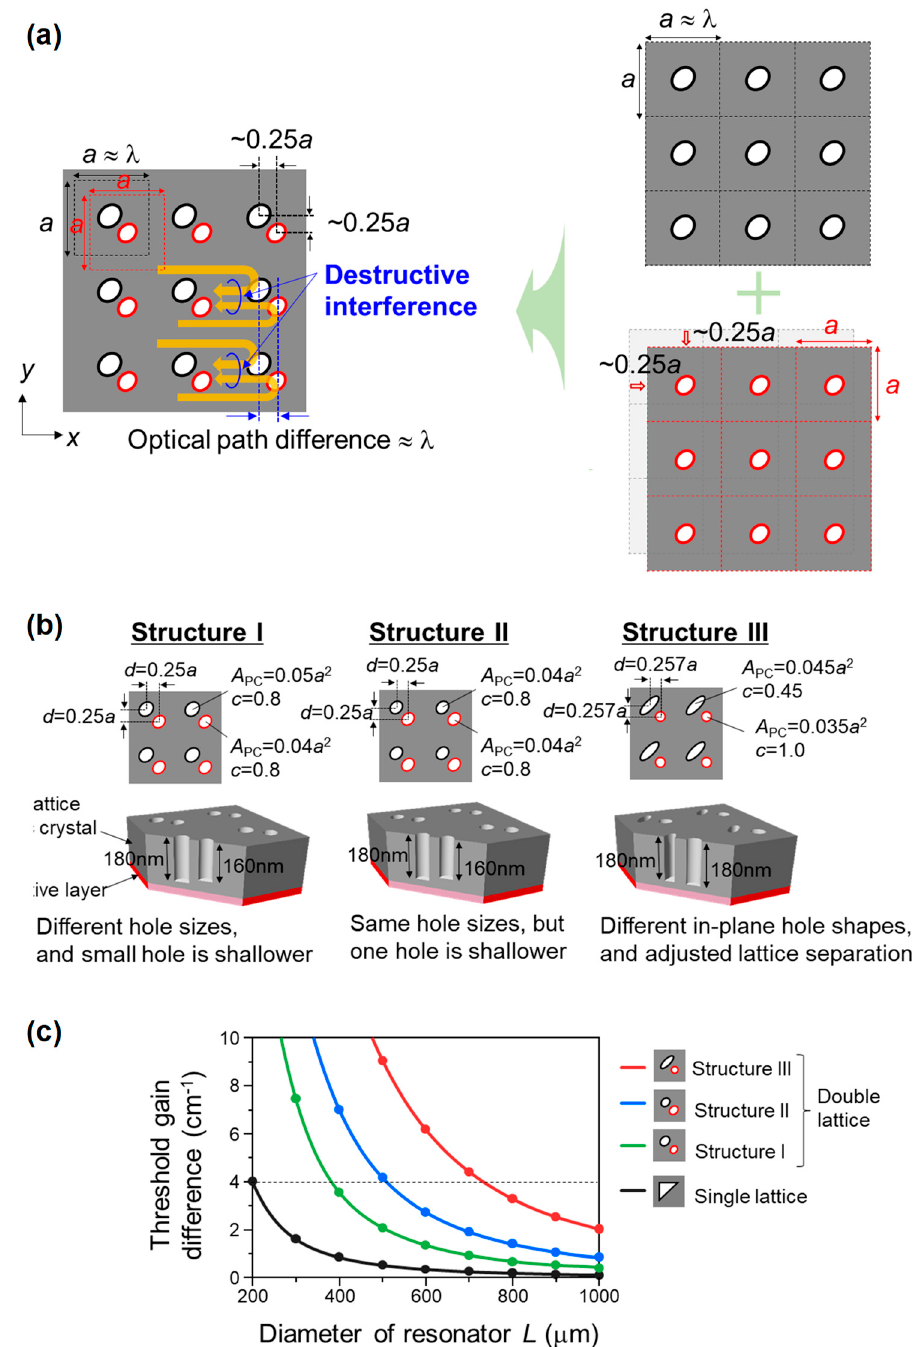
Figure 11. ( a ) Schematic of a double-lattice photonic crystal resonator for large-area photonic crystal lasers. ( b ) Three types of double-lattice photonic crystal resonator designs (Structure I–III). ( c ) Threshold gain difference of the fundamental and first higher-order modes with respect to the diameter of the resonator, calculated by three-dimensional coupled wave analysis. Reprinted by permission from Springer Nature, Nature Materials [16], 2019.